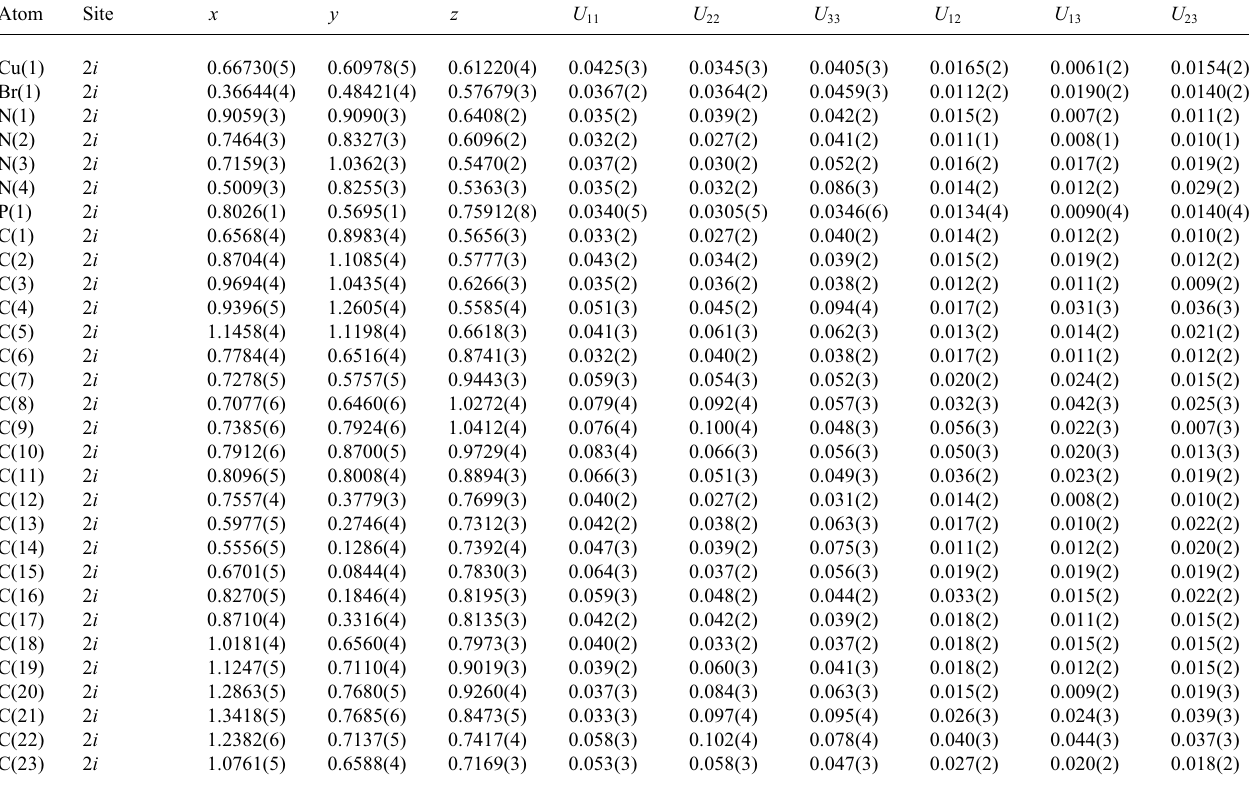
Table 3. Atomic coordinates and displacement parameters (in Å 2